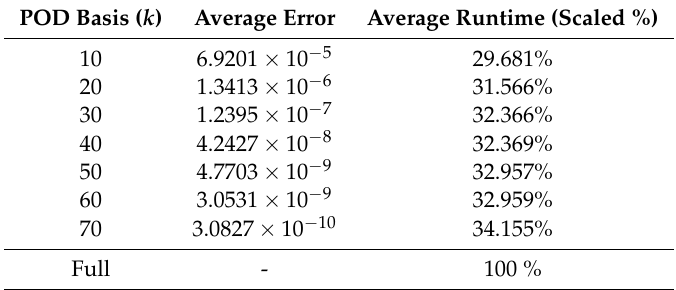
Table 7. [Test 3] Average runtime and average error of the POD reduced systems with parameter values (cid:101) = 0.0105, 0.01, and 0.0095,